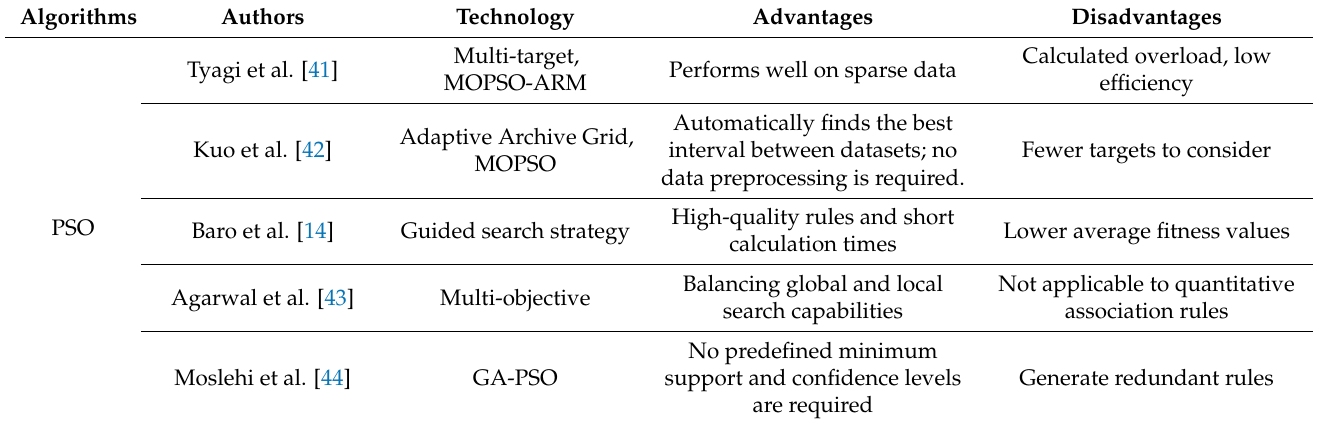
Table 2. ARM, based on swarm intelligence